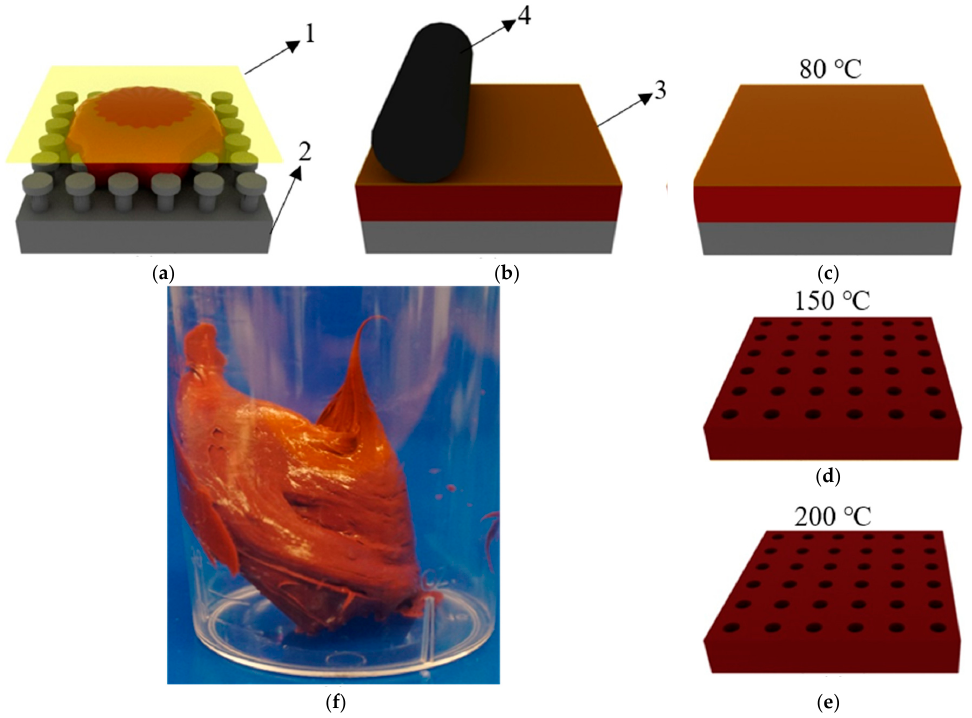
Figure 1. Fabrication process of making fluorosilicone mold. 1: Thin film; 2: mold; 3: fluorosilicone; 4: roller; ( a ) The film is coved on fluorosilicone with the mold; ( b ) Modified lamination; ( c ) Curing at 200 ◦ C; ( d ) Curing at 150 ◦ C after demolding; ( e ) Post-curing at 200 ◦ C after the film is peeled off; ( f ) Photo of fluorosilicone after